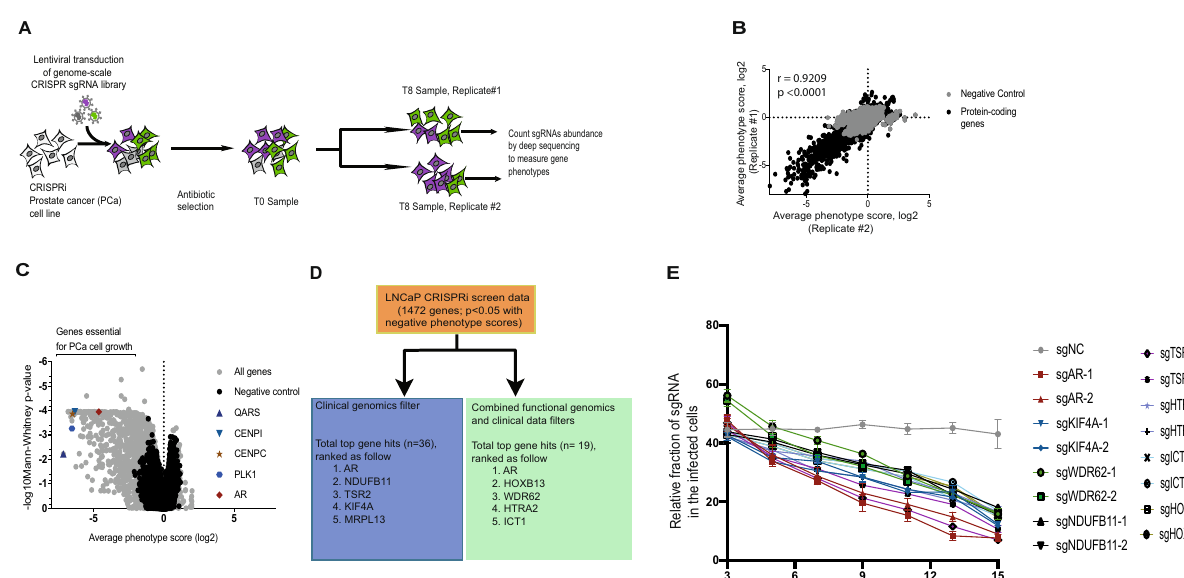
Fig. 1 Genome-scale CRISPRi screen to identify prostate cancer-speci fi c driver genes. A Schematic of growth-based CRISPRi screens; B Correlation plot showing concordance between replicates of the CRISPRi screen in LNCaP cells (LNCaPi) at gene level; C Volcano plot showing Mann – Whitney statistical signi fi cance and average phenotype score of all genes and negative controls; D Filtering strategies implemented to identify genes that are speci fi c to prostate cancer biology in the context of metastasis; E Competitive growth-based assay to validate top eight hits ( n = 3 as biological replicates; Mean ±